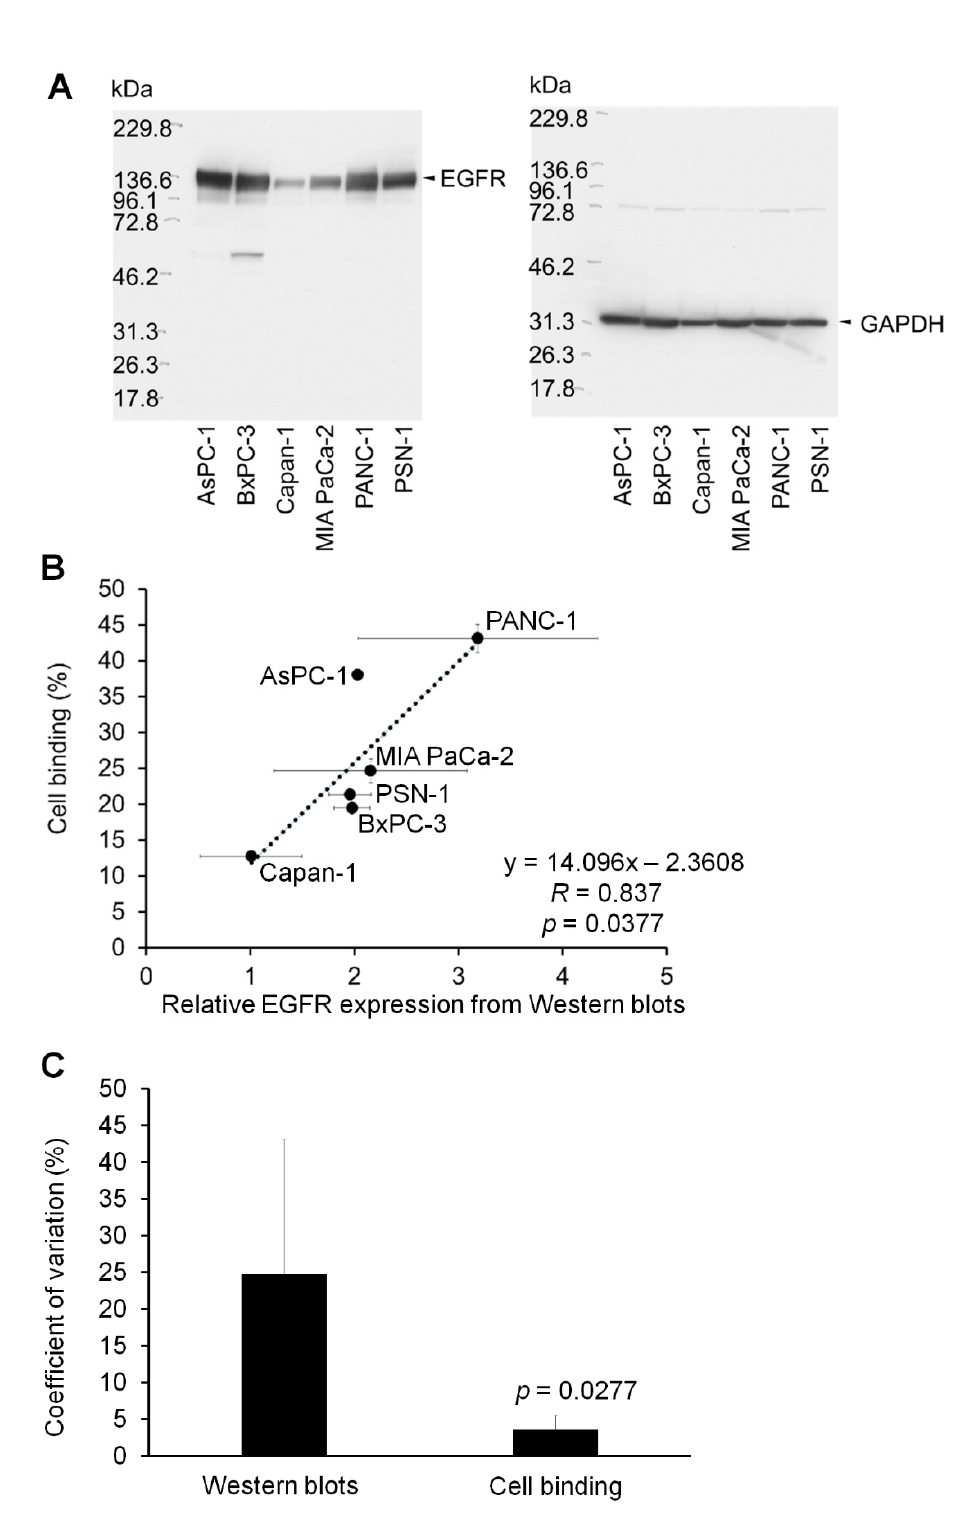
Figure 3. Relationships between Western blots for EGFR expression and in vitro cell-binding assay with 64 Cu-anti-EGFR antibodies (cetuximab). ( A ) Representative images of Western blots for EGFR and GAPDH expression. ( B ) Correlation between relative EGFR expression (EGFR/GAPDH) from Western blots and cell binding (%) from an in vitro cell-binding assay with 64 Cu-anti-EGFR antibodies (cetuximab). ( C ) Coefficient of variation (%) for relative EGFR expression from Western blots (Western blots) and cell binding (%) from an in vitro cell-binding assay (cell